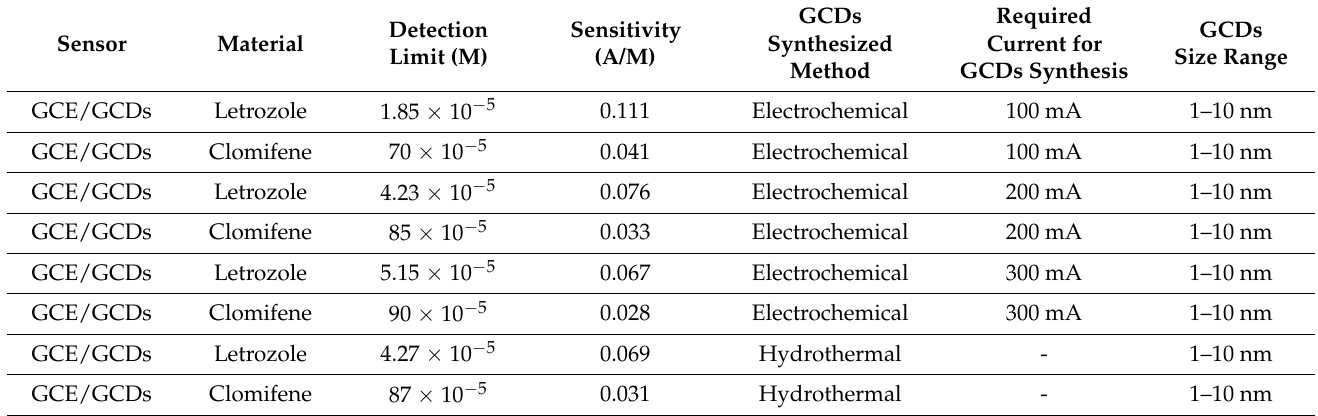
Table 5. Detection limit of different sensors